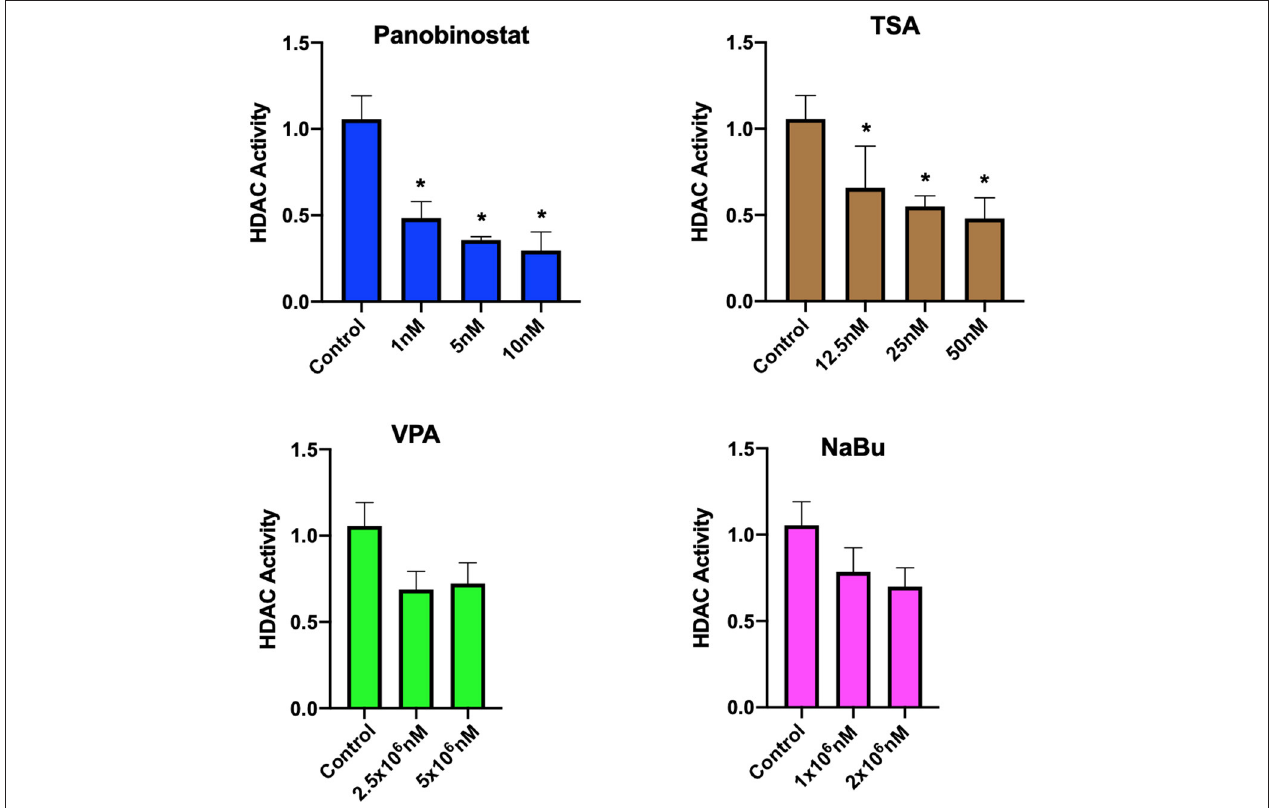
FIGURE 3 | Assessment of HDAC activity in CEF upon HDACi treatment. HDAC activity of crude nuclear extract from 1 × 10 7 cells was determined in untreated cells and HDACi treated CEF. Data are normalized to untreated control. Each experiment was conducted four times using two different CEF lines. Data are presented as mean ± SEM. Two-stage step-up method of Benjamini, Krieger, and Yekutieli for controlling false discovery rate was used for multiple comparison corrections. *False discovery rate adjusted p < 0.05.